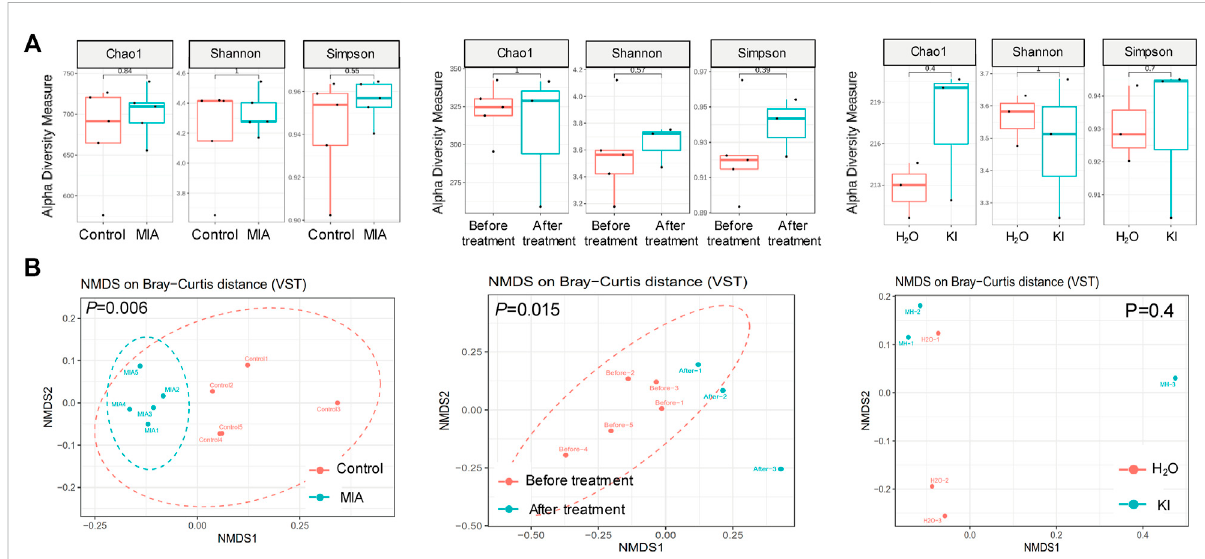
FIGURE 5 Modulation of fecal microbiome distribution in maternal immune activation (MIA) offspring after oral KI Essence extract treatment. Fecal microbiome pro fi ling of male MIA offspring was performed through high-throughput 16S rRNA gene sequencing. (A) Alpha diversity of fecal microbiota and (B) principal coordinate analysis plots (as obtained through nonmetric multidimensional scaling with Bray – Curtis distance analysis) for control and MIA rats before and after H 2 O and KI Essence extract treatment. Permutational multivariate analysis of variance (vegan::adonis, 1000 permutations) revealed a signi fi cant difference in beta diversity, which was quanti fi ed using a betadisper (vegan::betadisper, 1000permutations).Adonisandbetadisperindicesyielded p valuesof < 0.05and > 0.05,respectively. n =5forcontrolandMIAgroup; n =5forbefore treatment group; n = 3 for after treatment, H 2 O, and KI Essence extract treatment